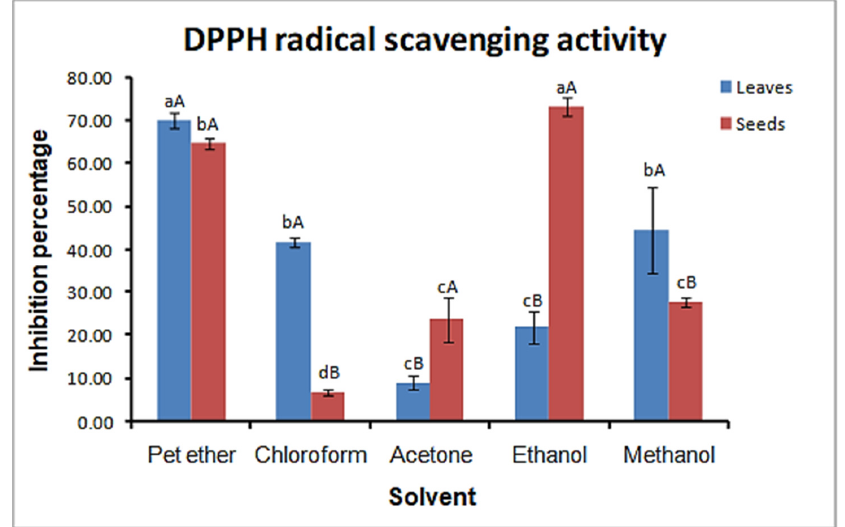
Figure 2. The DPPH radical scavenging activity of leaves and seeds extracts of Mucuna pruriens (L.) DC The small letter on error bars denotes the significant difference between various solvents and capital letter denotes significant difference between leaves and seeds at significance level